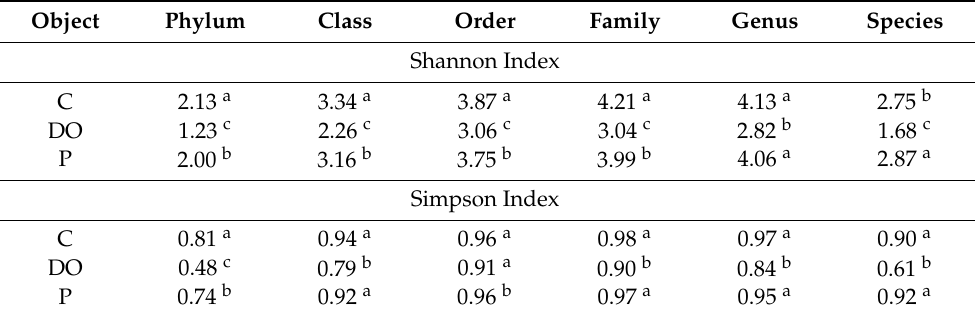
Table 1. Shannon and Simpson indices calculated from the abundance of operational taxonomic unit OTU.